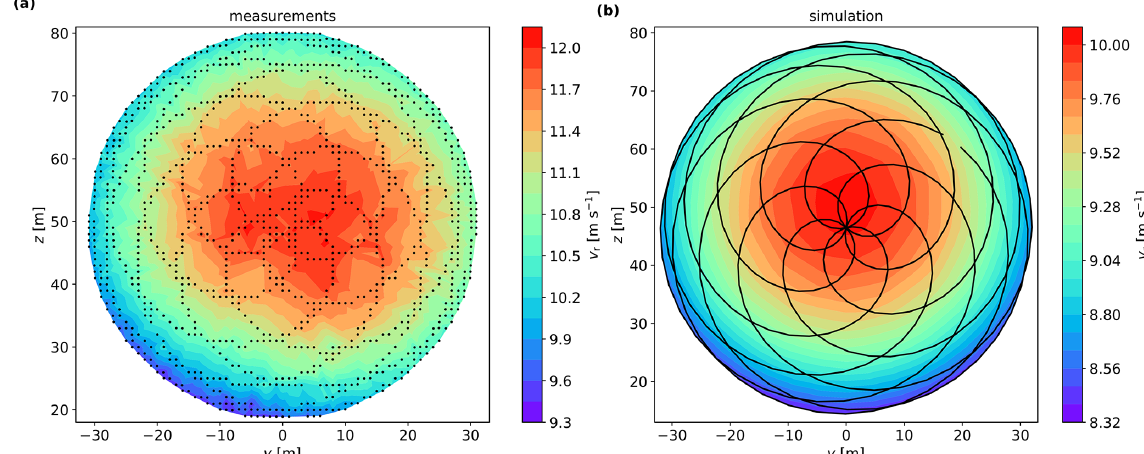
Figure 8. (a) Contour map of the median-derived radial velocity from the ensemble-average Doppler spectra in a 10min period. Black dots indicate the location of the grid cells with more than 30 Doppler spectra. (b) Contour map of the average median-derived radial velocity from SpinnerLidar simulations using 30 turbulence